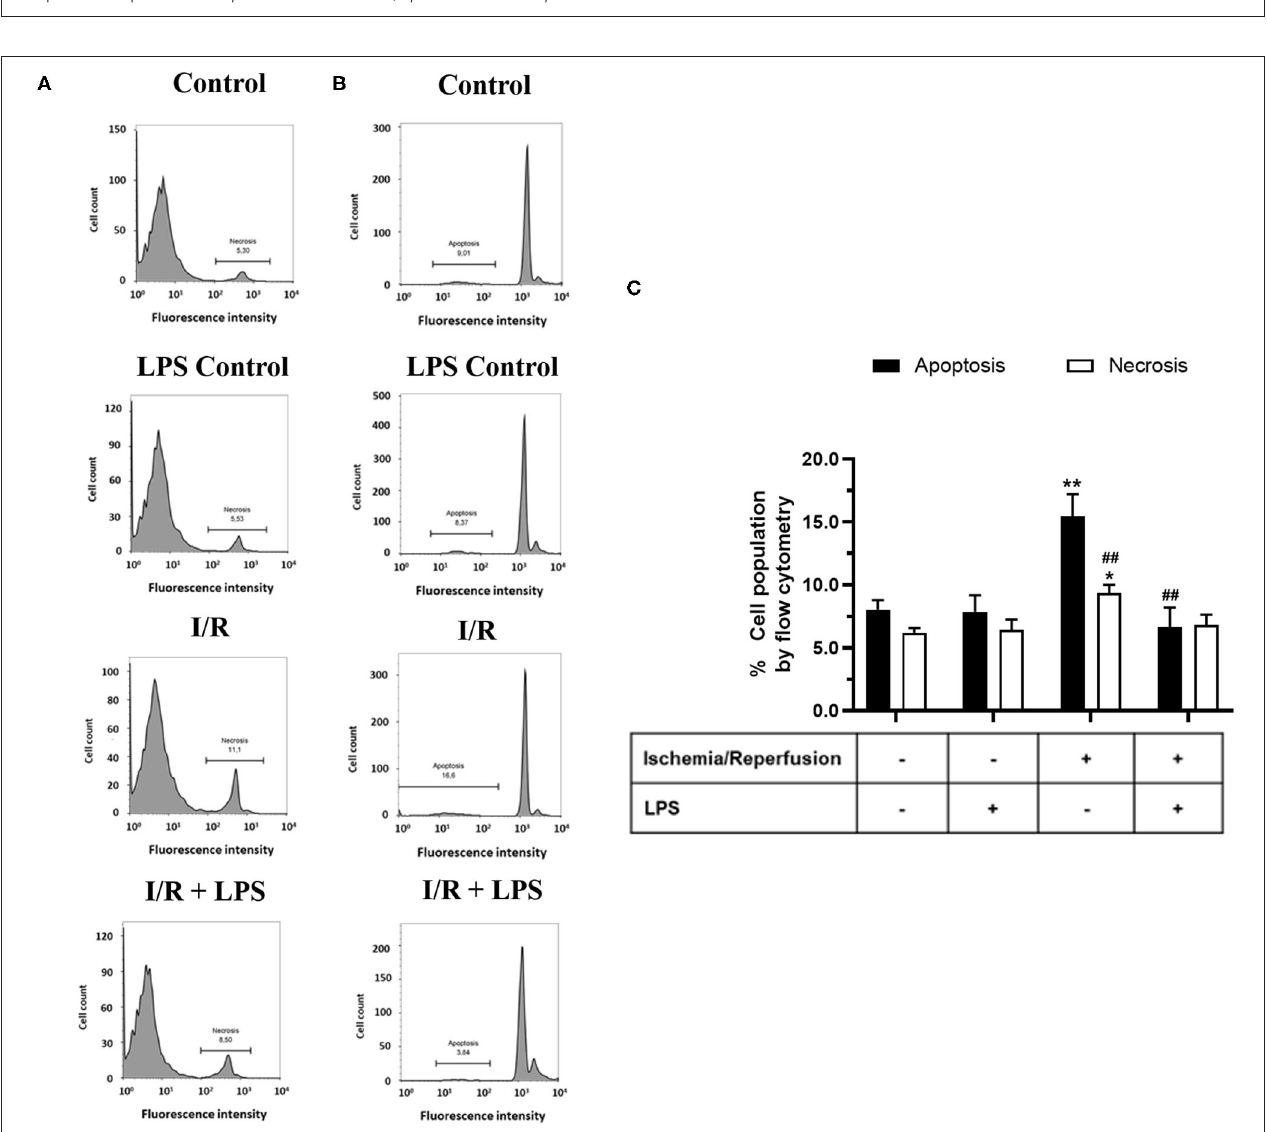
FIGURE 2 | (A,B) Effects of preconditioning (PC) with LPS. Cardiac fibroblasts were pretreated with LPS (1 µ g/ml) for 24 and 16h before performing sI/R. (C,D) Effect of LPS only during ischemia. Cardiac fibroblasts were treated with LPS (1 µ g/ml) during the 8h of ischemia and then were perfused (16h). (E,F) Effect of LPS only during reperfusion. Cardiac fibroblasts were treated with LPS (1 µ g/ml) only during the 16h of reperfusion. (G,H) Effect exerted by LPS during ischemia and reperfusion. Cardiac fibroblasts were treated with LPS (1 µ g/ml) during the 8h of ischemia and the 16h of reperfusion. Results are expressed as mean ± SEM of six